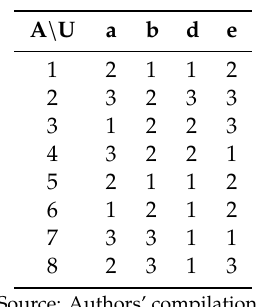
Table 3. Attribute table after